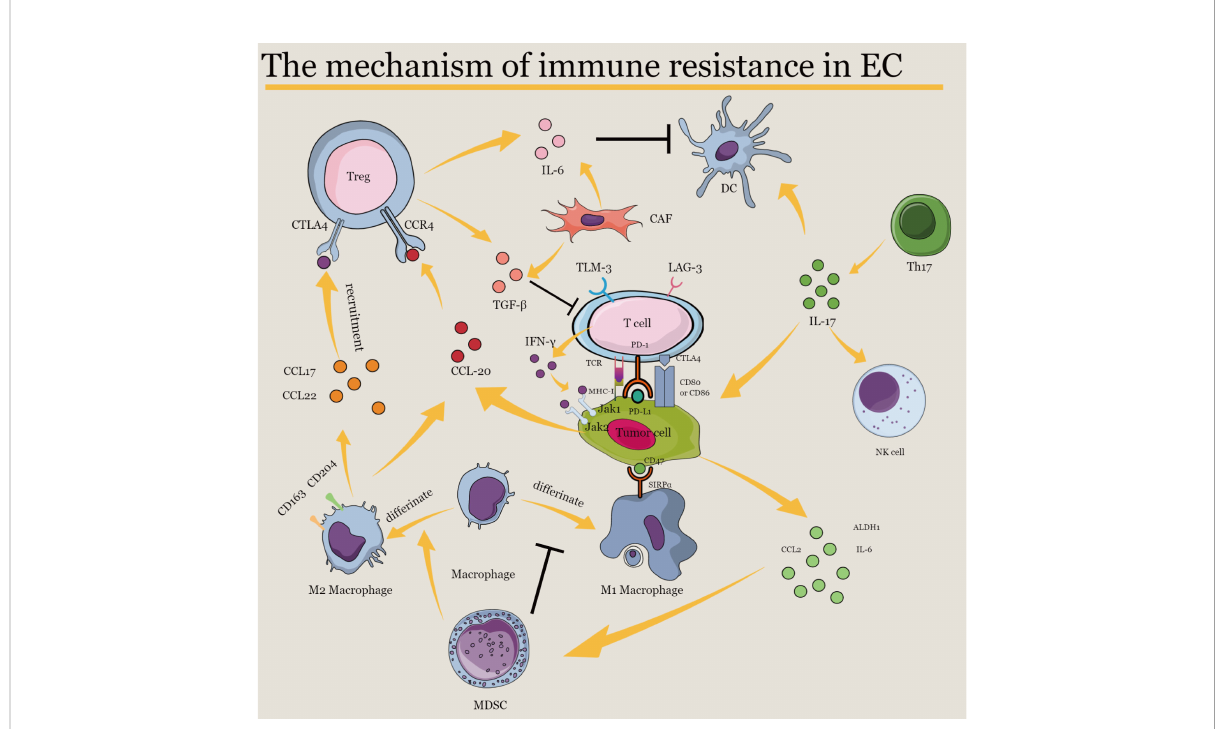
FIGURE 2 The mechanism of immune resistance in EC. IL-6, interleukin-6; IL-17, interleukin-17; PD-1, programmed cell death protein 1; PD-L1, programmed cell death ligand 1; CTLA-4, cytotoxic T lymphocyte-associated protein 4; CCR4, C – C chemokine receptor type 4; CCL2, C – C motif ligand 2; CCL17, C – C motif ligand 17; CCL20, C – C motif ligand 20; CCL22, C – C motif ligand 22; TGF- b , transforming growth factor- b ; TIM-3, T cell immunoglobulin and mucin-domain containing-3; LAG-3, lymphocyte-activation gene 3; IFN- g , interferon- g ; MHC-I,